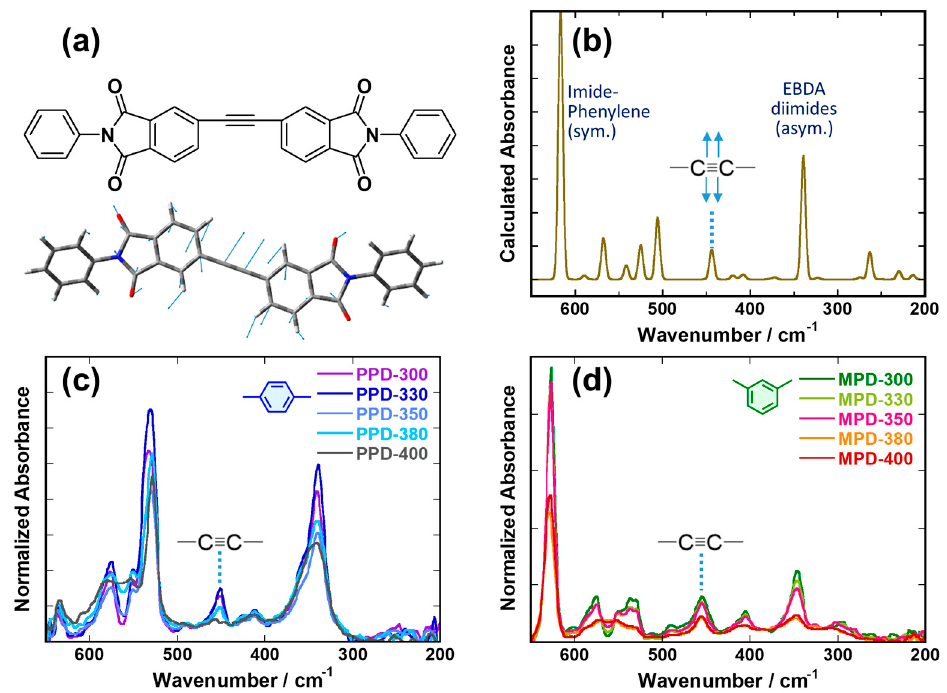
Figure 3. ( a ) Structure of a model used for DFT calculations, and the vibration mode corresponding to the symmetric rocking of the –C ≡ C– structure (445 cm − 1 ); ( b ) calculated far-IR absorption spectrum of the model; and experimental far-IR absorption spectra of ( c ) PPD-PI and ( d ) MPD-PI films cured at different temperatures. Table 2. Degree of crosslinking ( D C, %) of the PI films cured at different temperatures. Polyimide